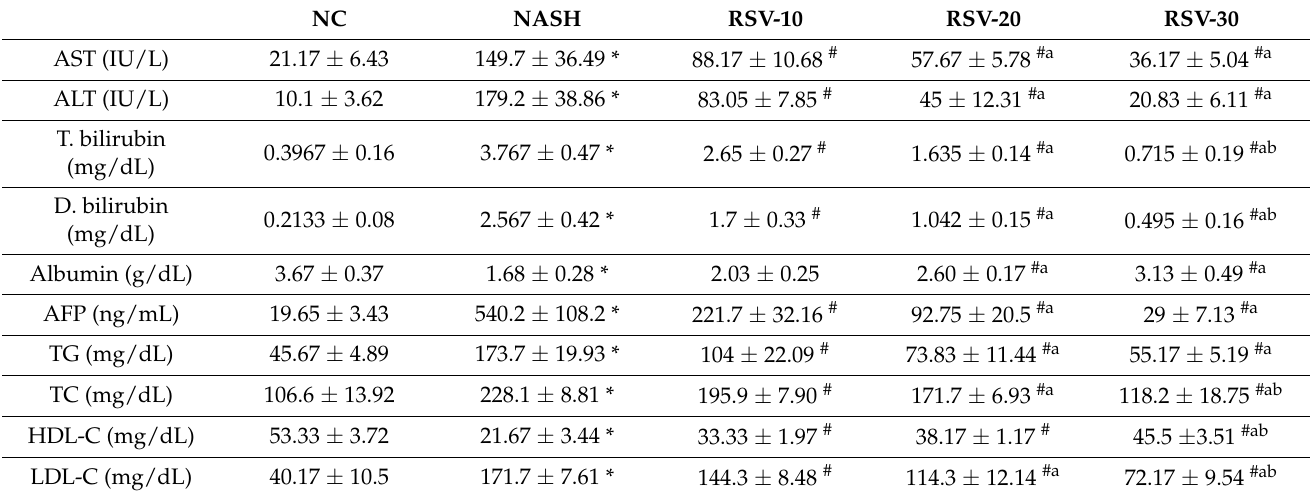
Table 1. The effect of rosavin treatment on liver function and lipid